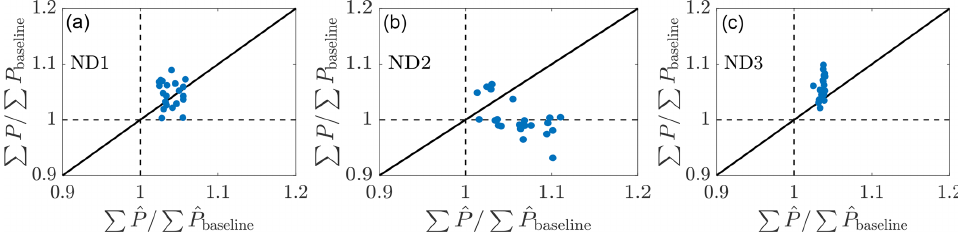
Figure 15. Relationship between the LES wind farm power production compared to the wake model wind farm power production prediction for (a) online control using the initial parameters to initialize the next state (ND1), (b) online control using the previous optimal parameters to initialize the next state (ND2), and (c) the static state estimation control (ND3). The LES power production is given by P , and the wake model prediction is given by ˆ P